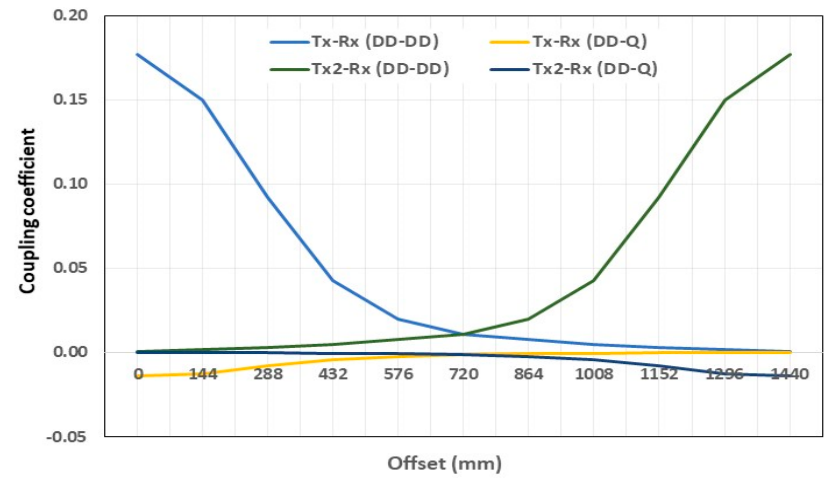
Figure 25. Variation of the coupling coefficient (k) for every step of the Offset in the DD–DDQ configuration.